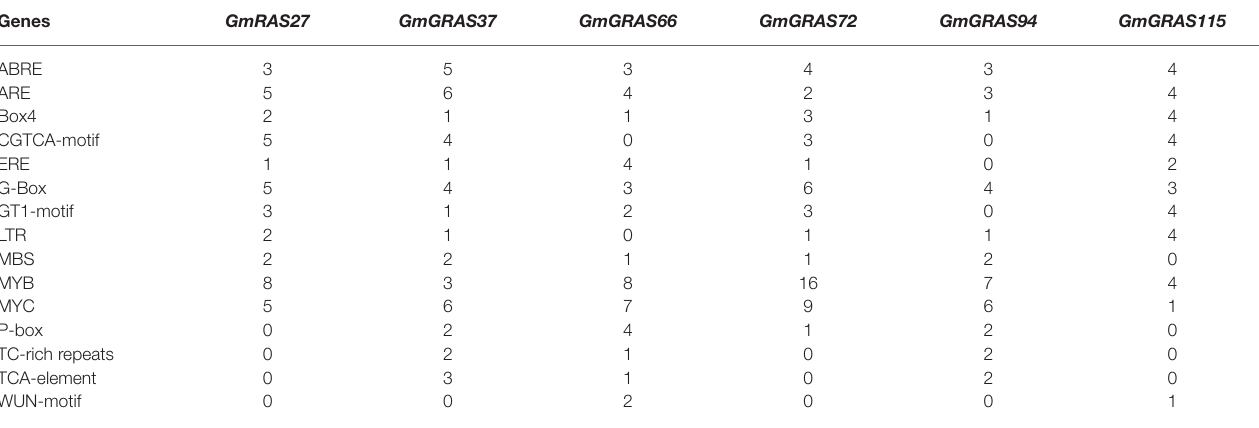
TABLE 1 | Distribution and numbers of cis -acting elements in the promoters of soybean GRAS genes.